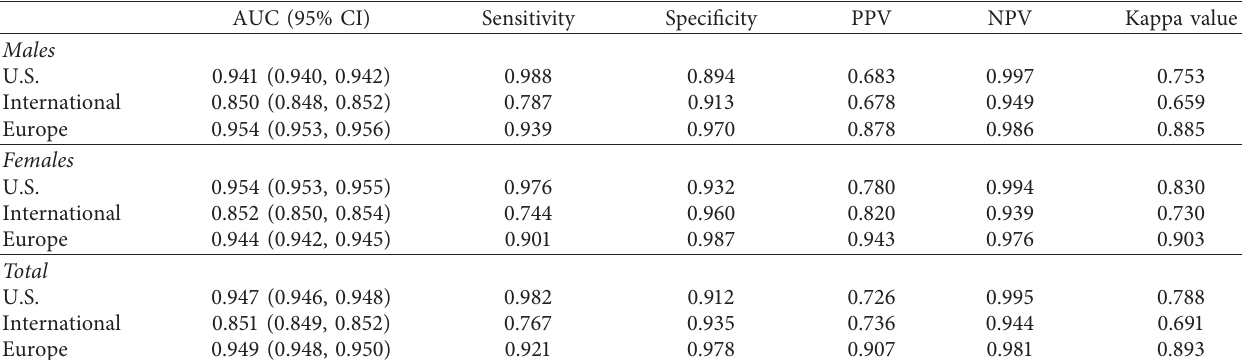
Table 5: Performance of the 3 other methods for the identification of high blood